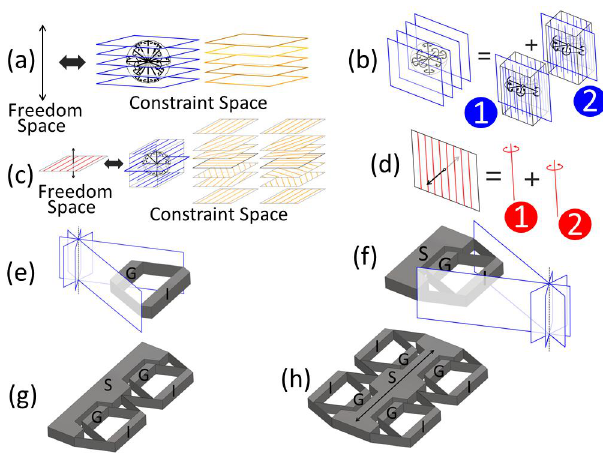
Figure 11. Desired system freedom and constraint spaces (a) , se- lecting the limbs’ constraint spaces (b) , complementary spaces (c) , selecting intermediate freedom spaces (d) , synthesizing flexure el- ements from intermediate constraint spaces (e) and (f) , synthesized hybrid system (g) , and symmetric version (h) .